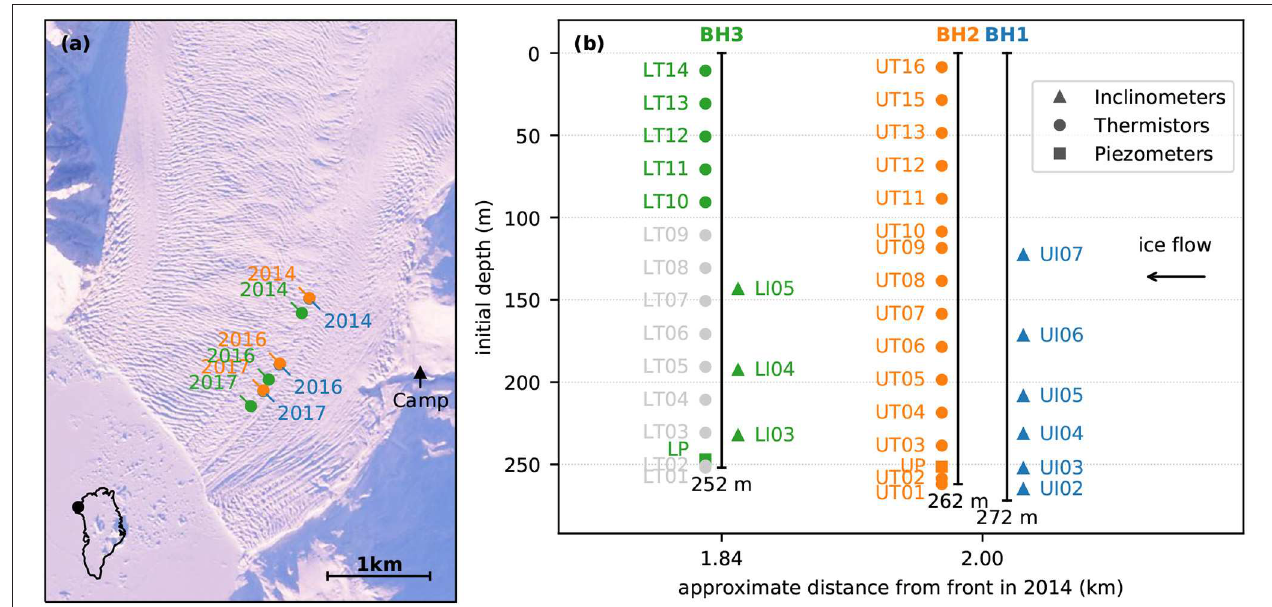
FIGURE 2 | (a) Bowdoin borehole locations from drilling in July 2014 to dismantling in July 2017 and background satellite image from 2017 Mars 10, 17:41:29 UTC. Contains modified Copernicus Sentinel data, processed with Sentinelflow. (b) Initial ice thickness and sensor depths. Inclinometers and piezometers are also equipped with